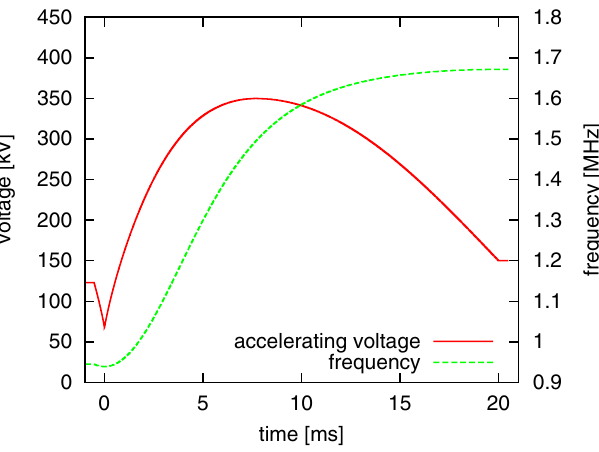
FIG. 21. (Color) Typical rf voltage pattern ( h ¼ 2 ) programmed in the 3 GeV acceleration mode.